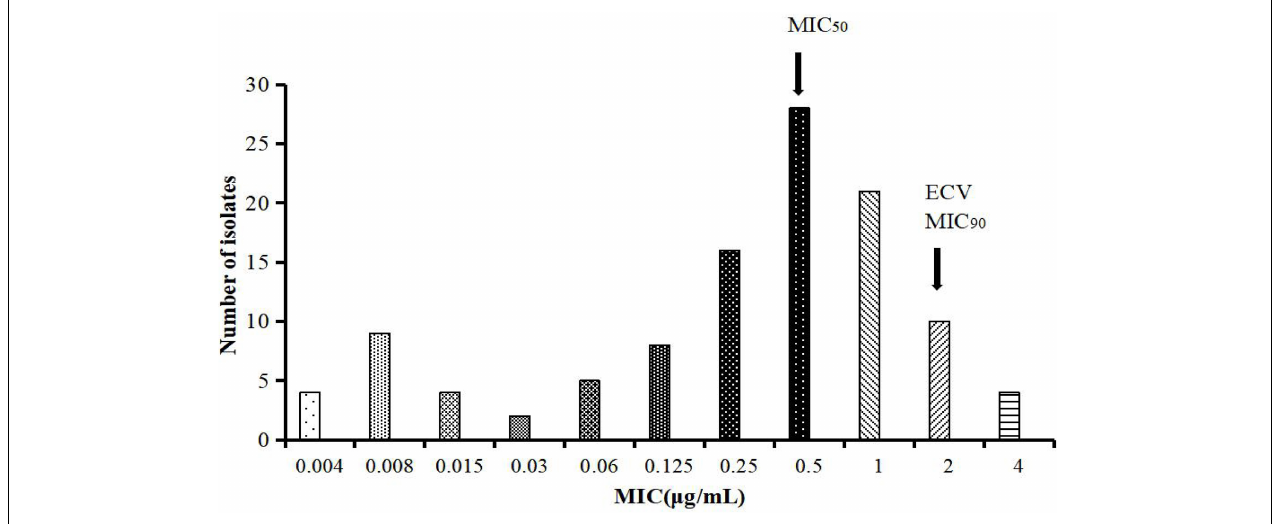
FIGURE 1 | MICs distribution of tylosin against 111 strains of